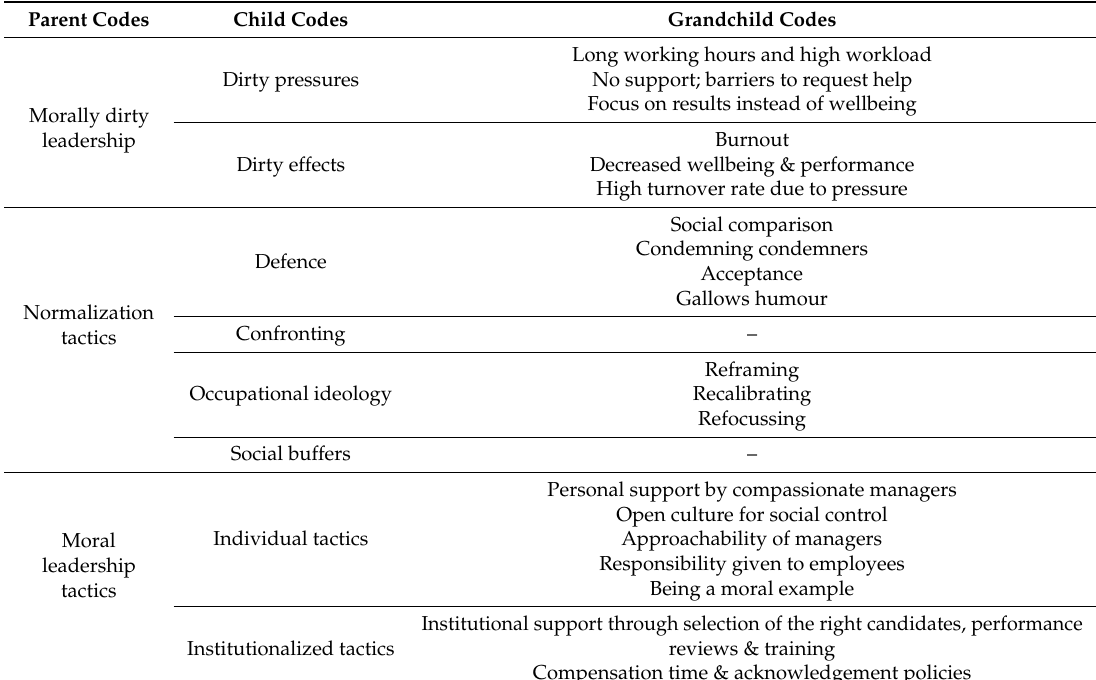
Table 4. Parent, child and grandchild codes.